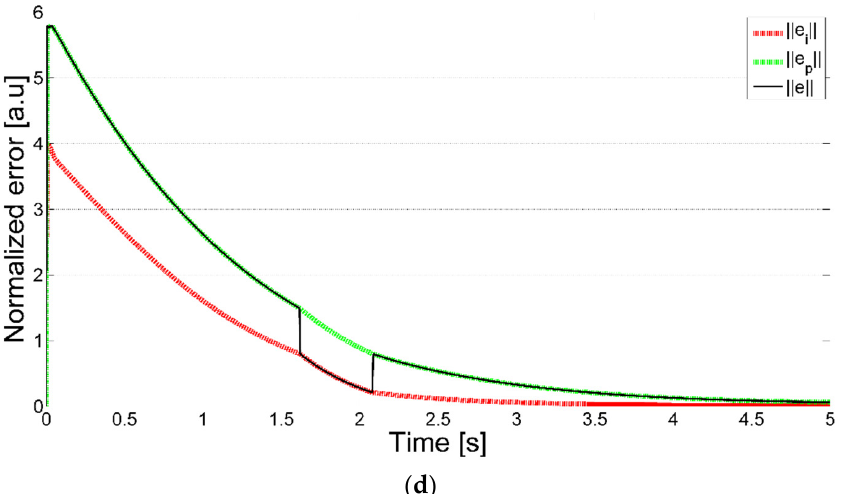
Figure 7. ( a ) Simulation of the image error evolution applied to IBVS Control (minimum error at 1.3 s) ( b ) Simulation of the position error evolution applied to PBVS Control (minimum error at 5 s). ( c ) Simulation of the error evolution applied to HBVS Control (minimum error at 2.1 s). ( d ) Results of the superposition of IBVS and PBVS image errors resulting in HBVS Control.